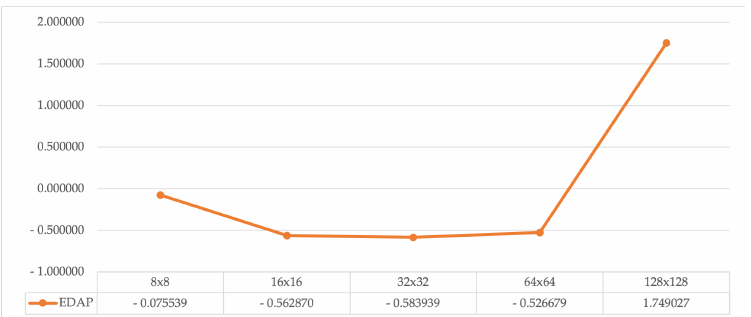
Figure 15. EDAP of different array